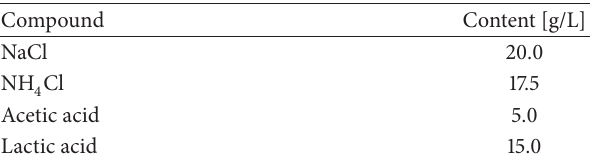
Table 2: Chemical composition of artificial sweat (pH adjusted to 4.7 by